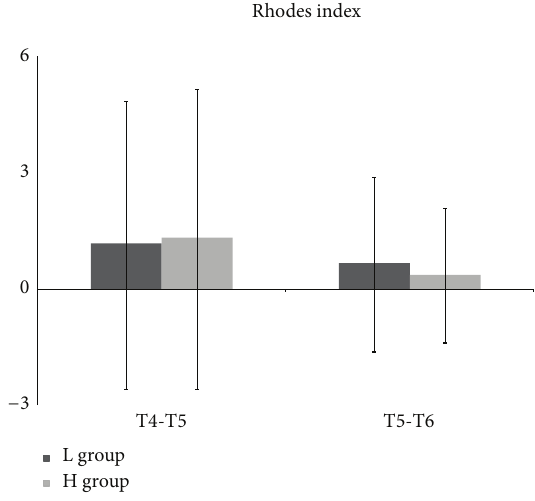
Figure 4: Severity of postoperative nausea and vomiting from 30 min after arrival at postanesthetic care unit (PACU) (T4) to 6 h after discharge from PACU (T5) and from 6 h after discharge from PACU (T5) to 24h after discharge from PACU (T6) using Rhodes index. L group: propofol-low dose remifentanil group; H group: propofol-high dose remifentanil